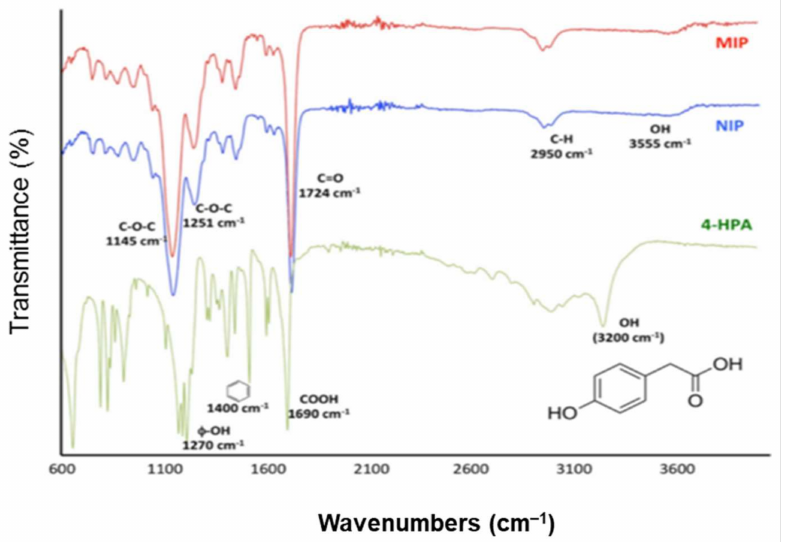
Figure 11. ATR-FTIR spectra for MIP, NIP, and 4-HPA [74].